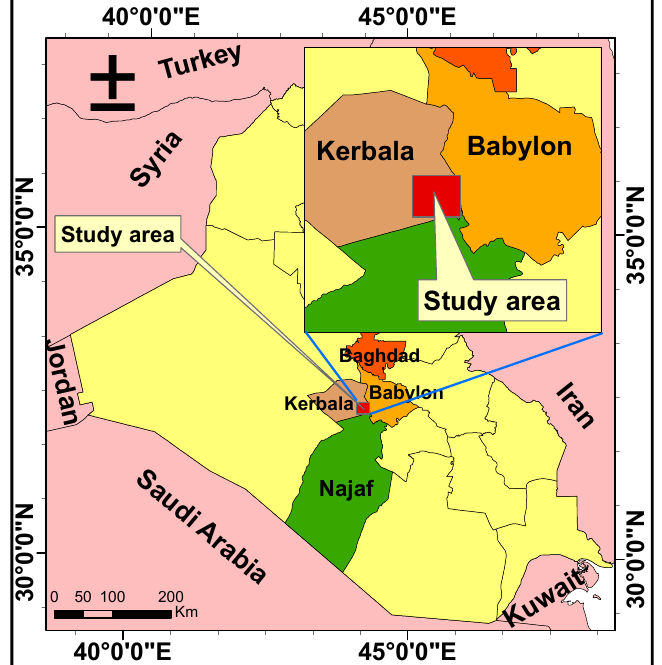
Figure 12. Karbala province—study area [11].